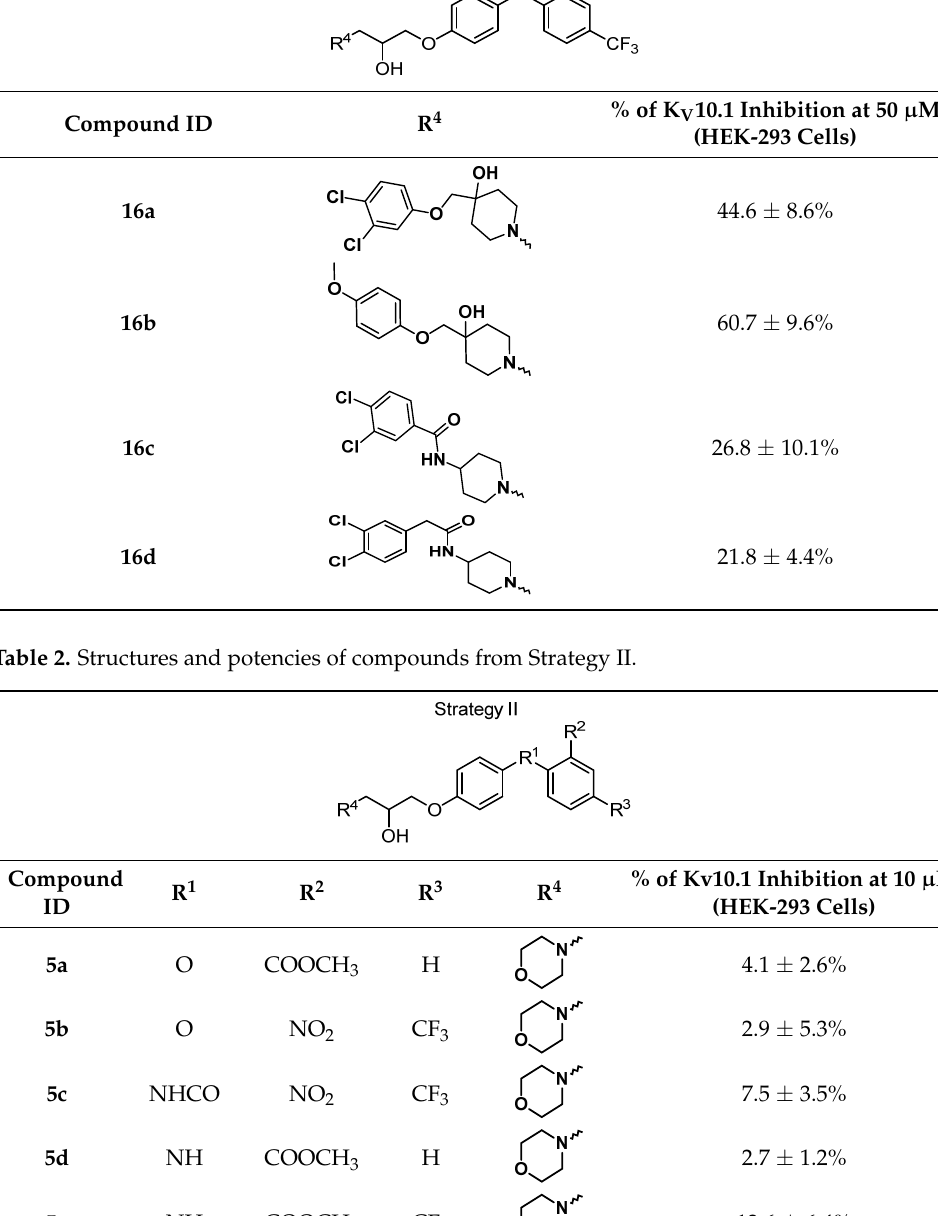
Table 1. Structures and potencies of compounds from Strategy I.